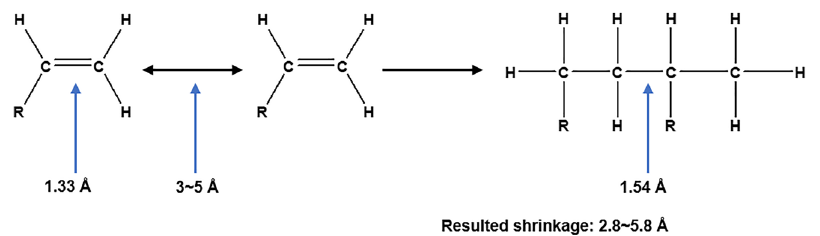
Figure 9: Change of distance in the polymerization. Originally in